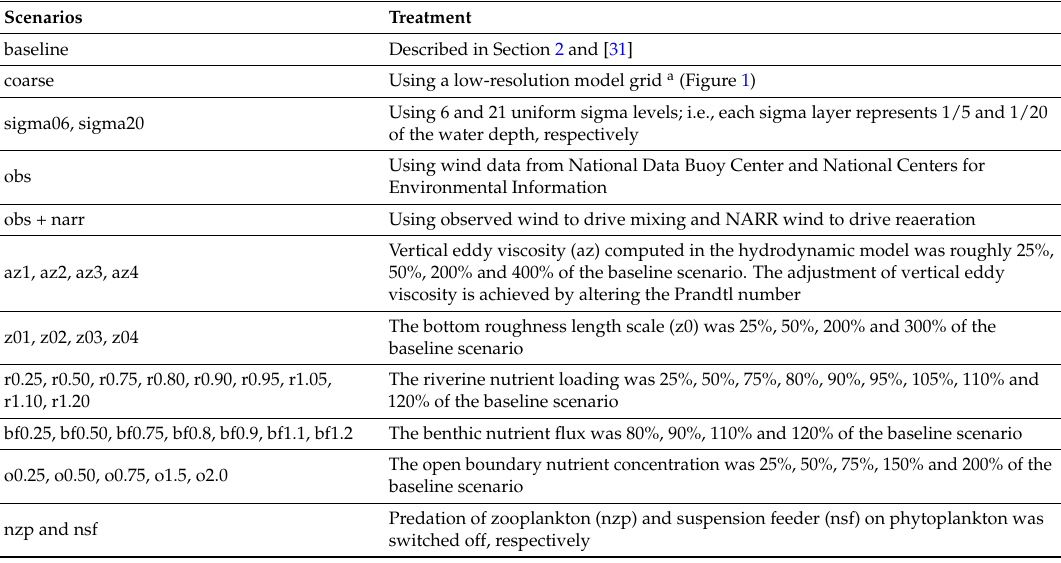
Table 2. A list of model sensitivity